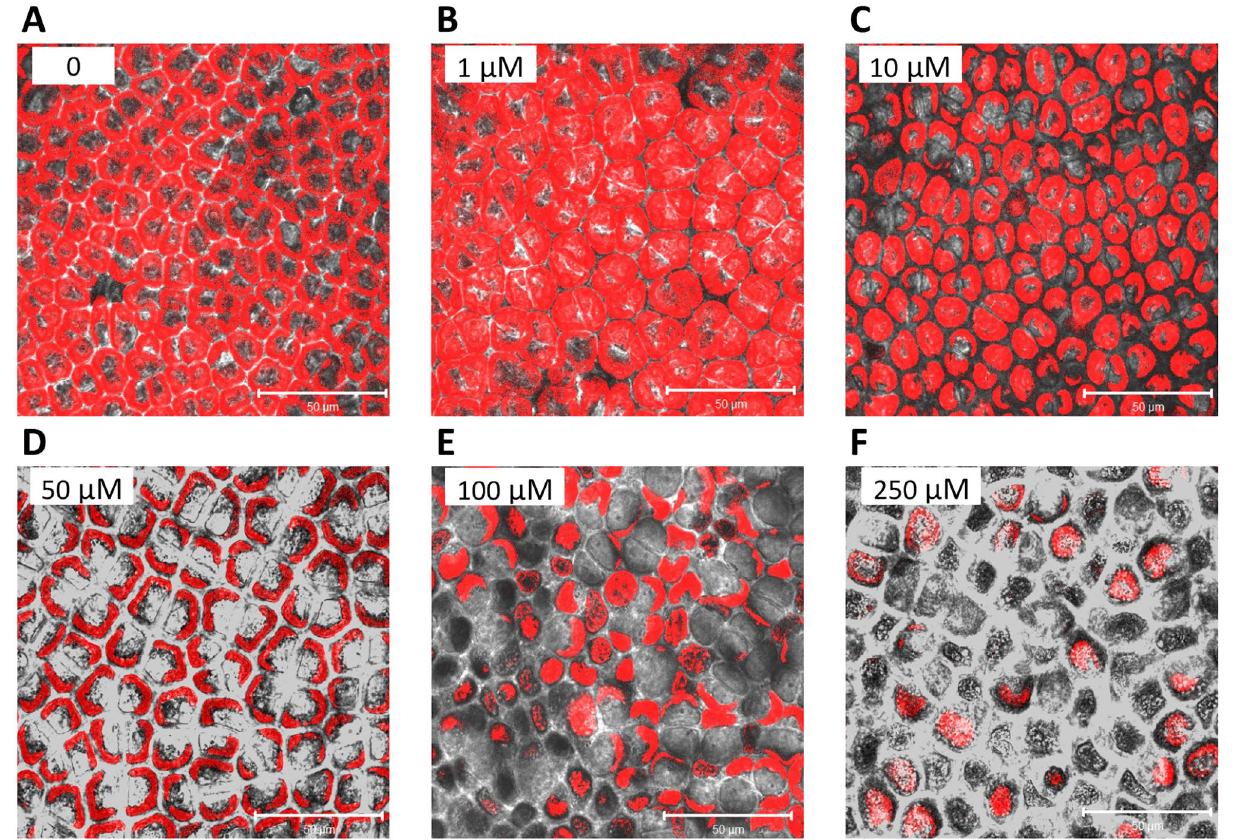
Figure 1. Visualization of U. lactuca cells cultivated with 0–250 μM of anthracene for 7 days. The viability of the cells was analyzed based on the red autofluorescence of chlorophylls in chloroplasts by confocal